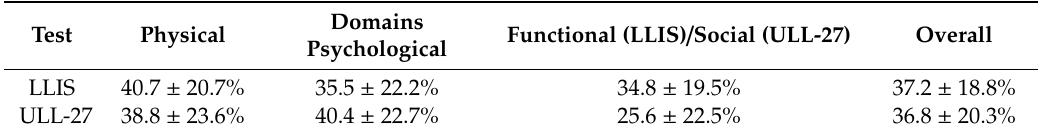
Table 3. Average impairment scores (%) of lymphedema life impact scale (LLIS) and upper limb lymphedema (ULL-27) patient reported outcomes.